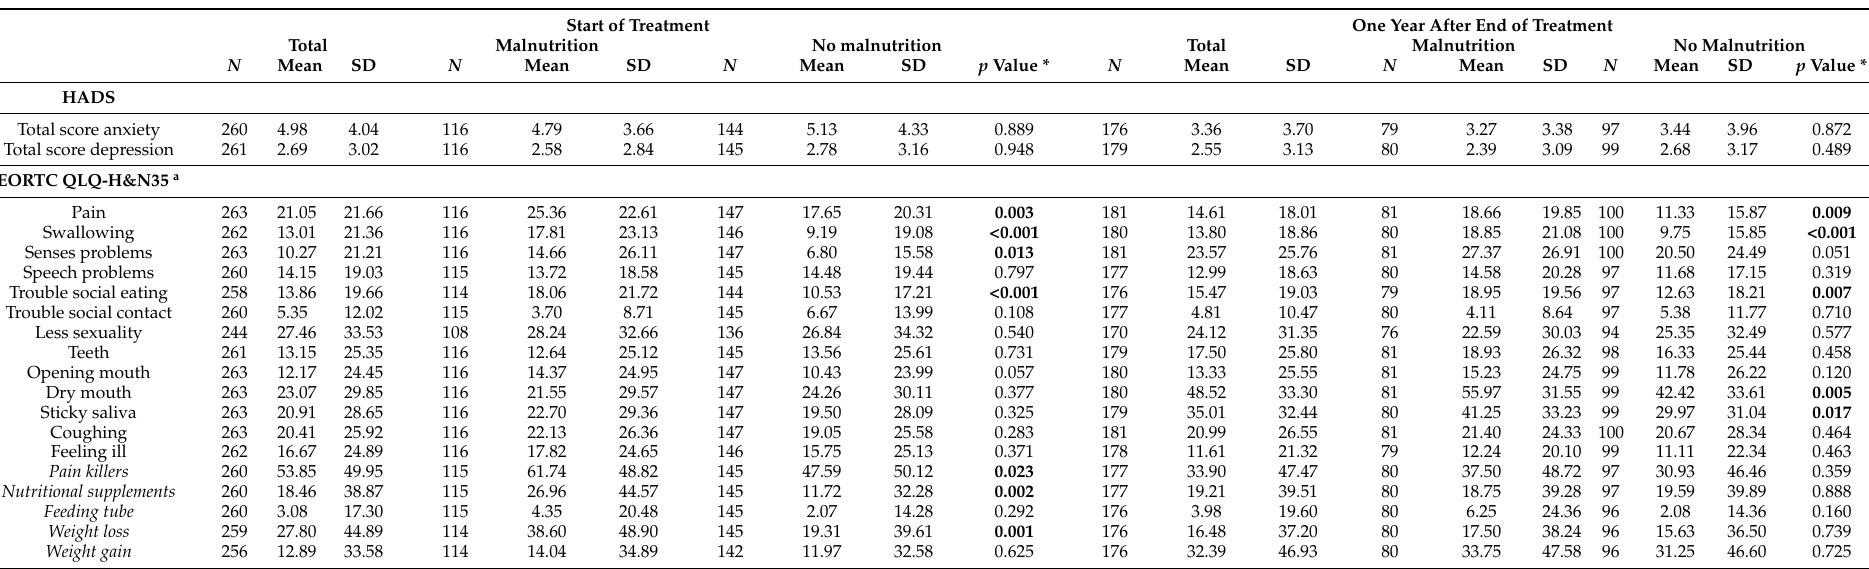
Table A1. Numbers (N), mean, and standard deviation (SD) on HADS and EORTC QLQ-H&N35 at the start of treatment for head and neck cancer and one year after the end of treatment, respectively. Data is shown for the group in total, patients with malnutrition defined by the Global Leadership Initiative on Malnutrition (GLIM), and patients without